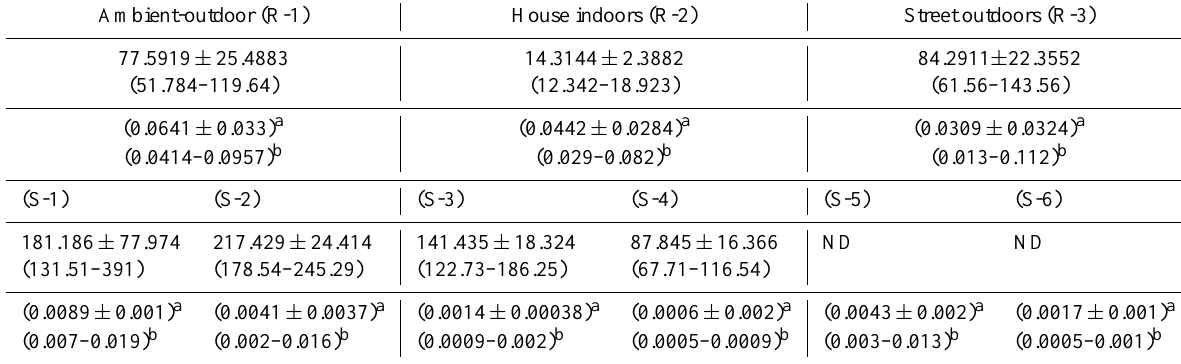
Table 2. Yearly average dust fallout (mtsqkm − 2 month − 1 ) monitored in selected classified receptor and source sites. Ambient-outdoor